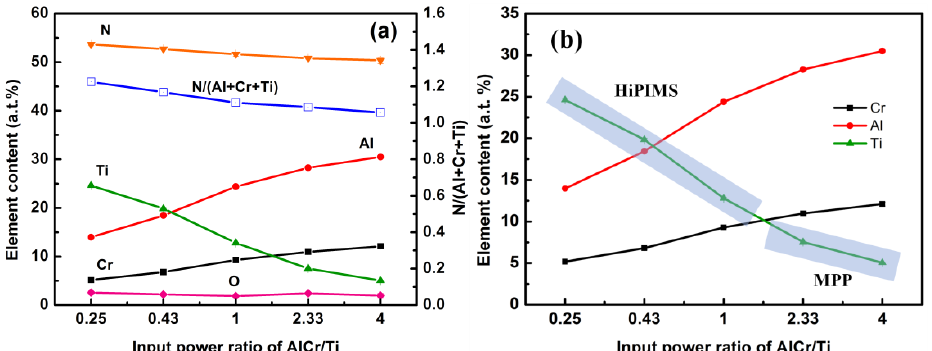
Figure 2. The relationship between ( a ) chemical composition, input power ratio of AlCr/Ti target and N/(Al + Cr +Ti) ratio and ( b ) the tendency of Ti, Al, and Cr contents in HiPIMS and MPP regions with respect to the input power ratio of AlCr/Ti target.